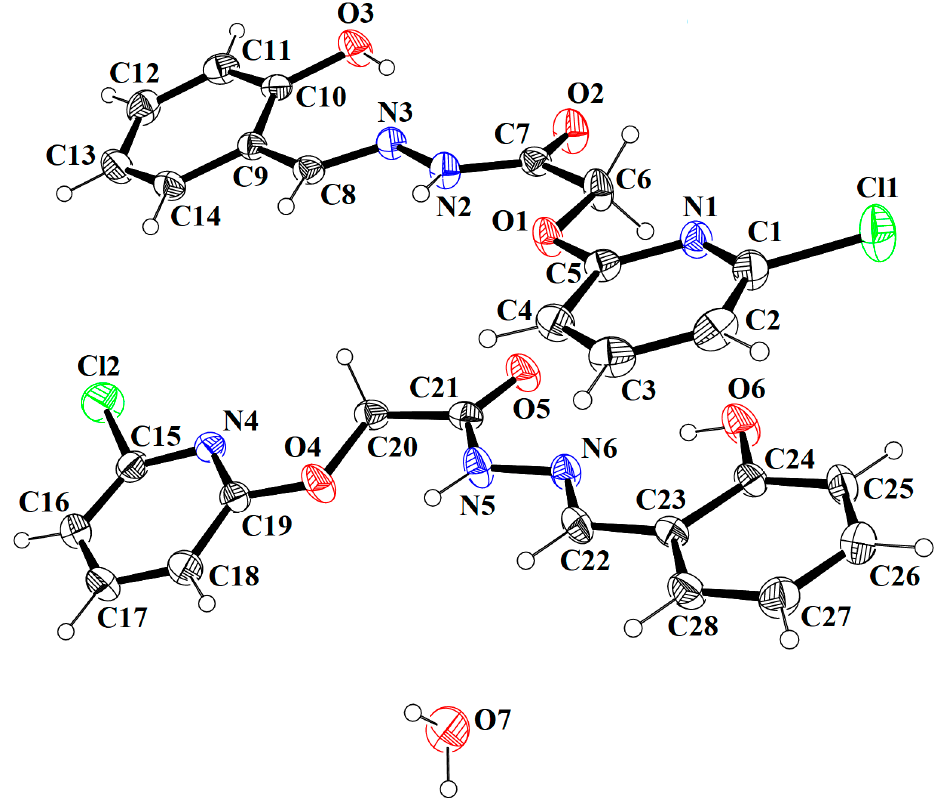
Figure 2. ORTEP diagram of HBPAH drawn at a probability level of 30% with H-atoms are displayed by tiny circles of arbitrary radii. Red color shows oxygens, blue nitrogen, green chlorine, white is for hydrogen, and black/white contours show carbon atoms.